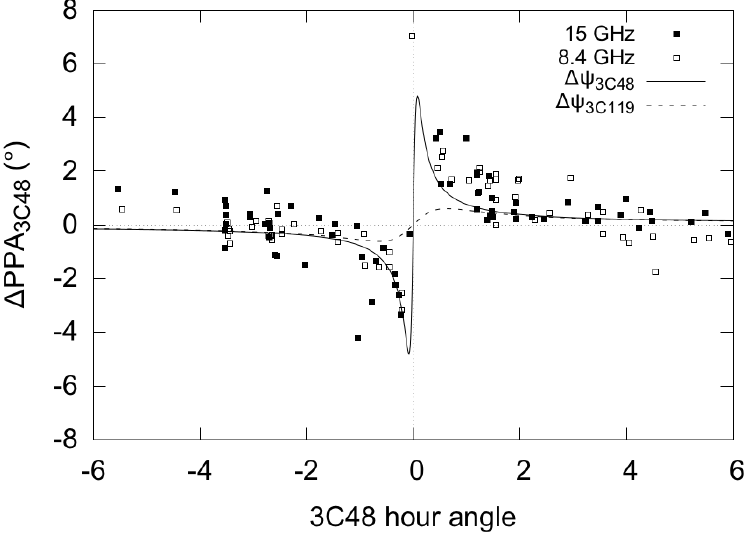
Figure 2. Polarization position angle (PPA) of 3C 48 relative to that of 3C 119. A very clear systematic effect is visible which is a function of the hour angle of 3C 48. The solid line is the theoretical error expected in the parallactic angle of the source for a latitude error of 10 arcmin. The origin of this effect remains unclear, but the fit can be used to correct the PPA calibration based on 3C 48 and the measured PPA of